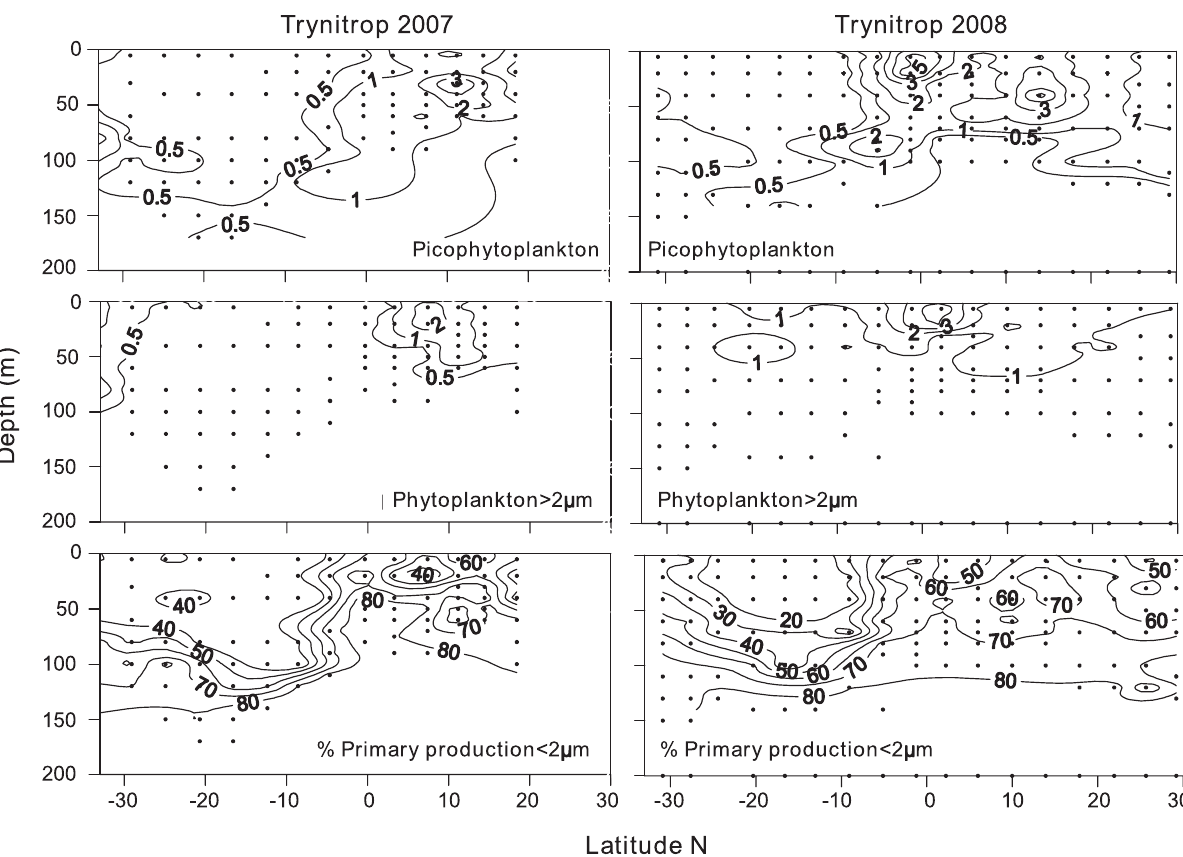
Fig . 6. – Latitudinal distribution of size-fractionated primary production (mg C m -3 d -1 ) and contribution of picophytoplankton to total primary production (%). Left panel, Trynitrop 2007; right panel, Trynitrop